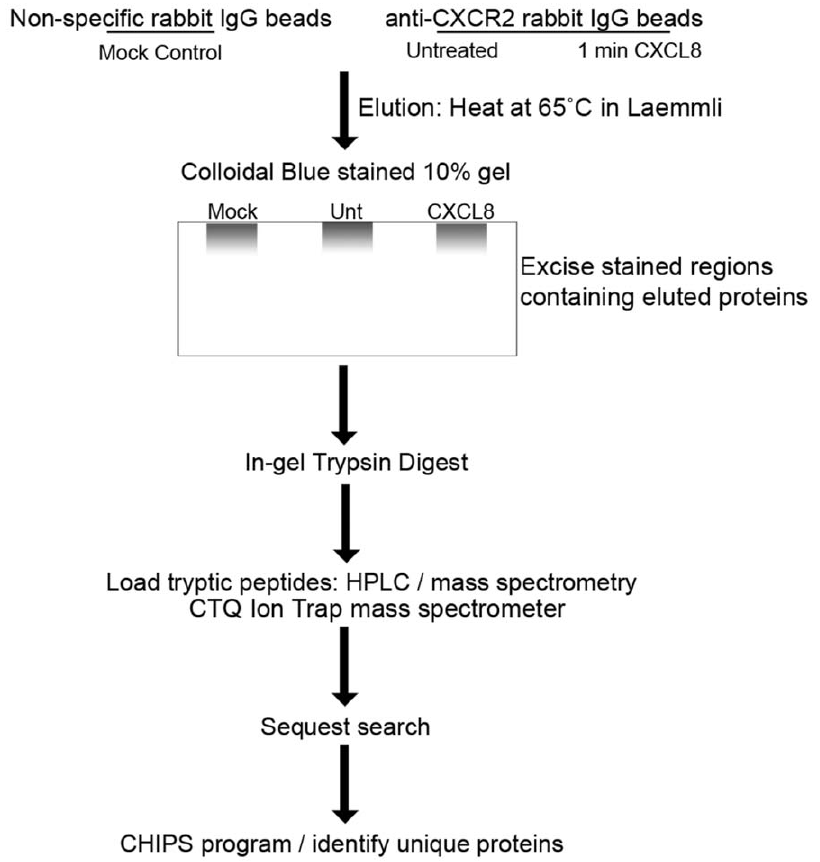
Figure 1. Schematic of representation of proteomics approach used to identify novel CXCR2-interacting proteins.